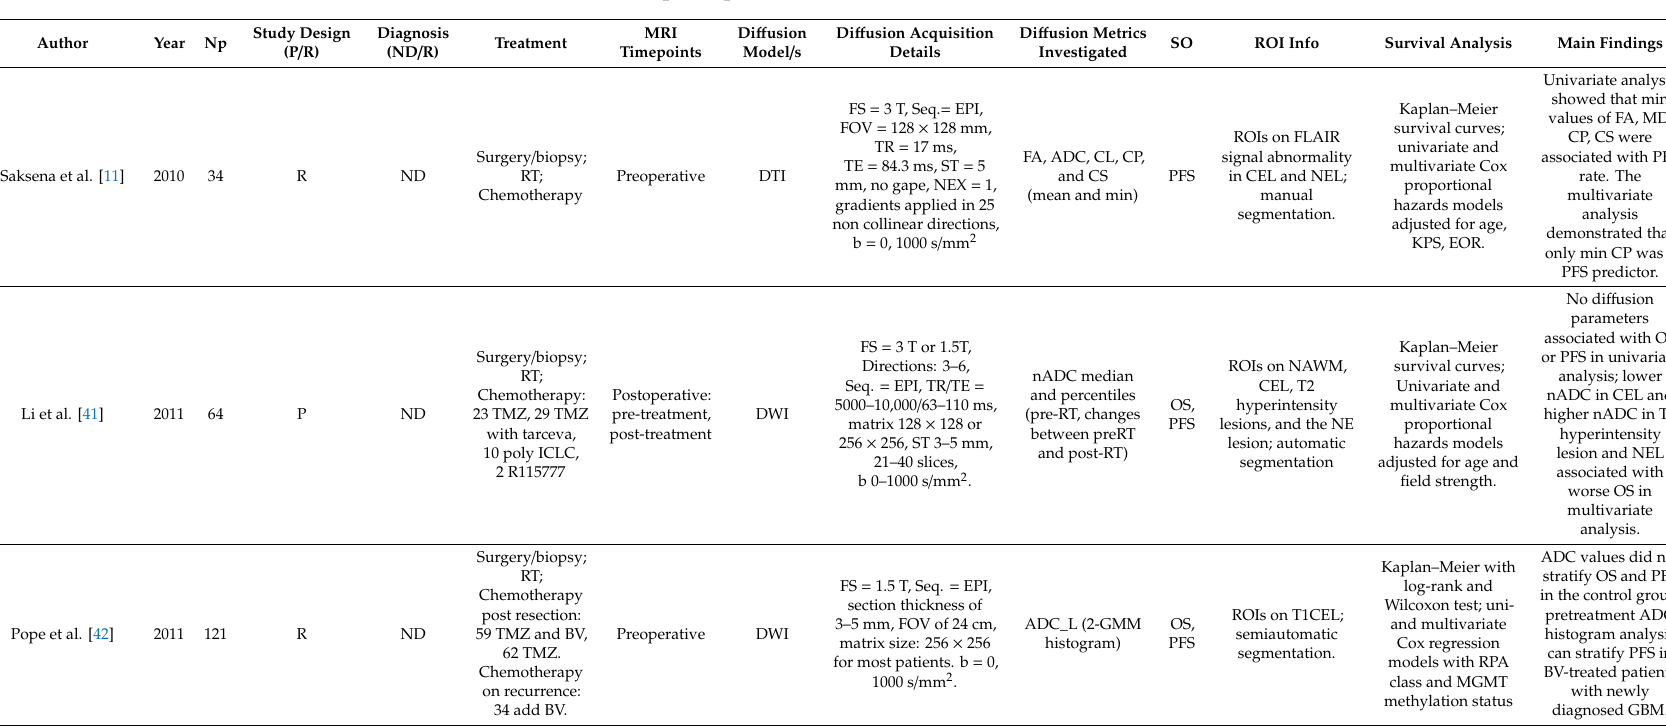
Table 1. Characteristics of the included studies. Abbreviations: P / R = Prospective / Retrospective; DWI = Di ff usion Weighted Imaging; DTI = Di ff usion Tensor Imaging; DKI = Di ff usion Kurtosis Imaging; IVIM = Intravoxel Incoherent Motion; SE = Stretched Exponential; RSI = Restriction Spectrum Imaging; SO = Survival